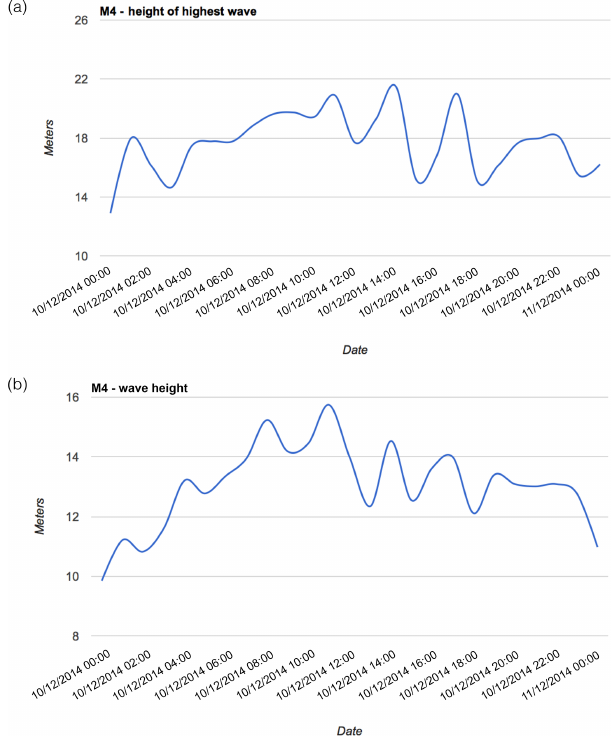
Figure 9. M4 records of (a) maximum wave height (m) and (b) significant wave height (m) on 10 December 2014. Data retrieved from The Marine Institute (2017a).